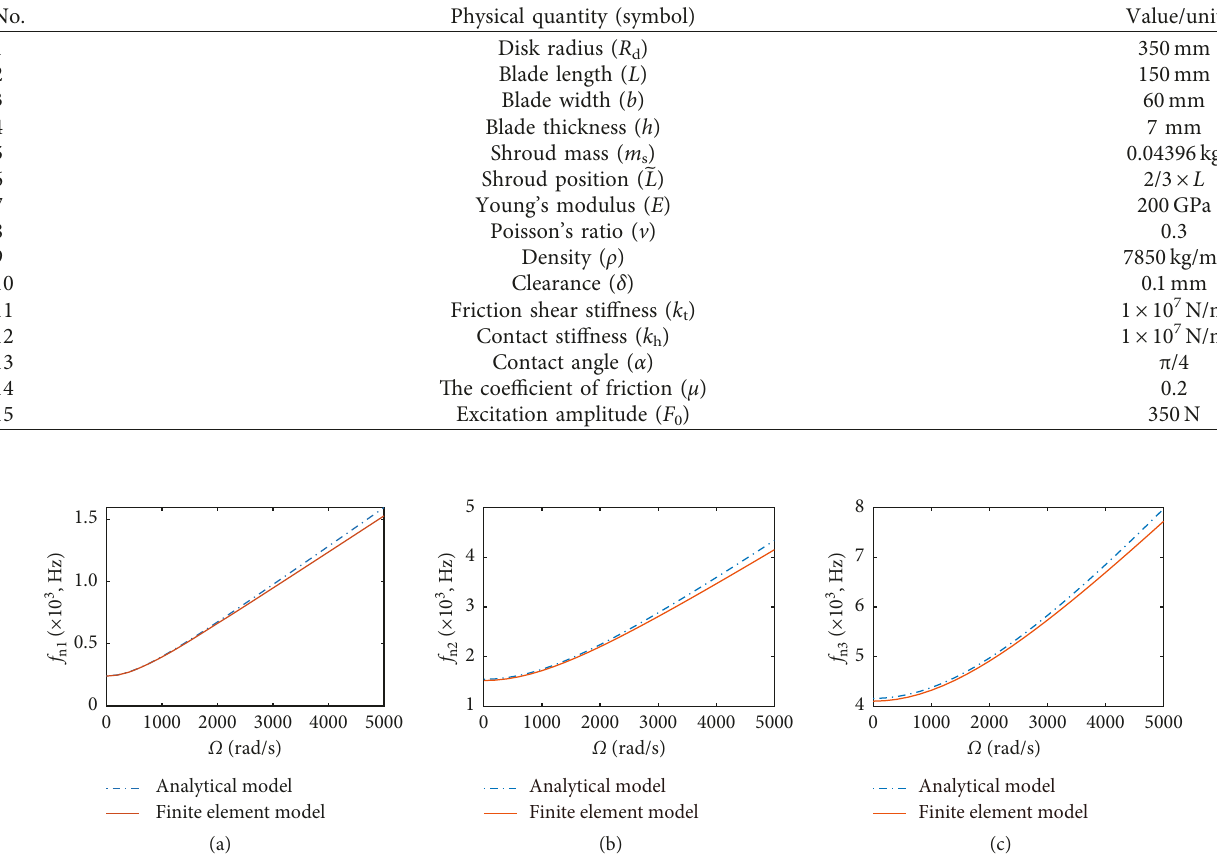
Table 1: The parameters of the rotating shrouded blade.